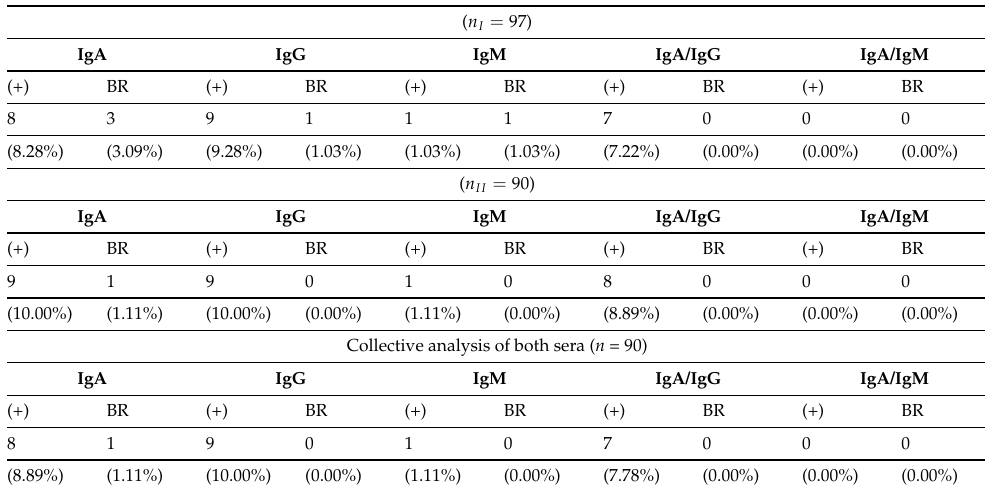
Table 3. Positive rates of the serological assay in HCWs* included in the study from Hospital no. 4 in Bytom. ELISA Test (Serological Assay) Outcomes BYTOM, Silesian Voivod.